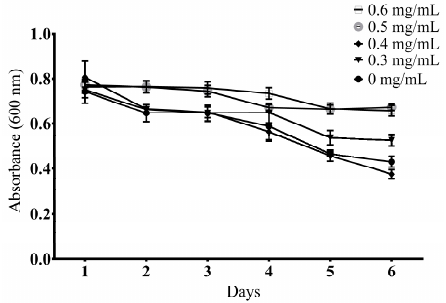
Figure 2. The daily OD values of Escherichia coli OP50 for each concentration level of EOL.